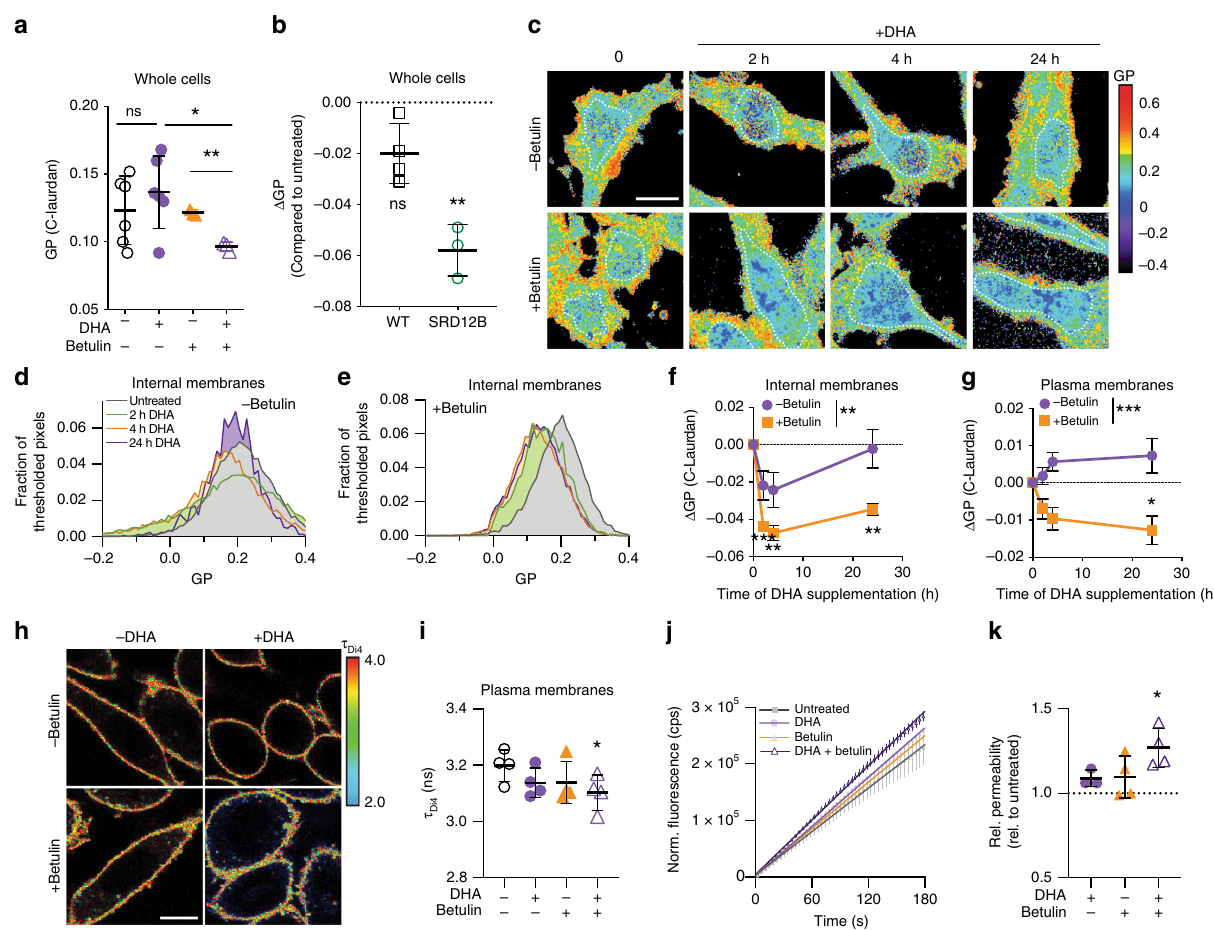
Fig 5 Physical membrane homeostasis is disrupted by inhibition of lipidomic response. a Spectroscopy of C-Laurdan-labeled homogenized whole cell membranes shows that neither DHA nor betulin alone affected membrane packing (GP) after 24 h, whereas DHA + betulin signi fi cantly reduced membrane packing. b Similarly, DHA supplementation had no effect on WT CHO cells after 24 h, whereas SRD-12B cells (defective in SREBP processing) had signi fi cantly reduced membrane packing. c GP maps of RBL cells treated with DHA and/or betulin demonstrate temporal changes in lipid packing (GP). The white dotted lines denote the areas from which the GP of the internal membranes was calculated. d , e GP histograms of internal membranes from images in c . Leftward shift in histograms denotes less tightly packed, more fl uid membranes. f , g Δ GP represents GP of treated cells normalized to untreated within each experiment. Internal membranes are initially fl uidized by excess DHA-containing lipids (purple), then recover to baseline by 24 h. In contrast, internal membrane packing does not recover in betulin-treated cells (orange). g DHA supplementation had no signi fi cant effect on packing at the plasma membrane (PM); however, when betulin is added to inhibit lipidomic remodeling, the PM also becomes signi fi cantly more fl uid upon DHA supplementation. The effect of betulin treatment in PMs was signi fi cant ( p < 0.001) by 2-way ANOVA. h Fluorescence lifetime imaging of Di4 to probe membrane packing in the PM. Warmer colors represent higher lifetimes (e.g. more tightly packed membranes). i Only the combined DHA + betulin treatment signi fi cantly reduced Di4 lifetime. j Exemplary plots of accumulation of fl uorescein fl uorescence during incubation with FDA. k PM permeability to FDA increases by treatment with DHA + betulin. Average ±SD for n ≥ 3 biological replicates. * p < 0.05, ** p < 0.01, *** p < 0.001. ( a ) is a student's t test between groups. ( b ), ( d ), ( e ), and ( k ) are one-sample t tests compared to untreated. ( f , g ) is a two-way ANOVA to compare effect of treatment; each time point for betulin-treated cells was signi fi cantly different from zero ( p < 0.01). ( i ) shows paired t tests compared to untreated. In ( j ), linear regressions are shown. Scale bars are 10 μ m. Source data are provided as a Source Data fi